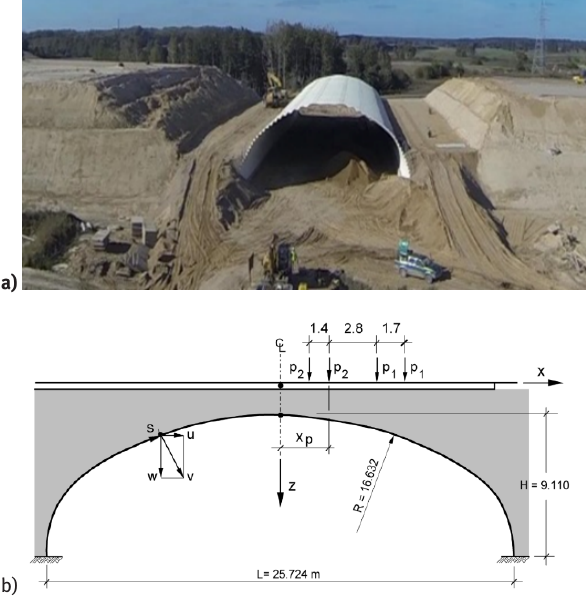
Figure 1: Photograph of the shell during backfilling (a) and geometry of its longitudinal cross section (b).